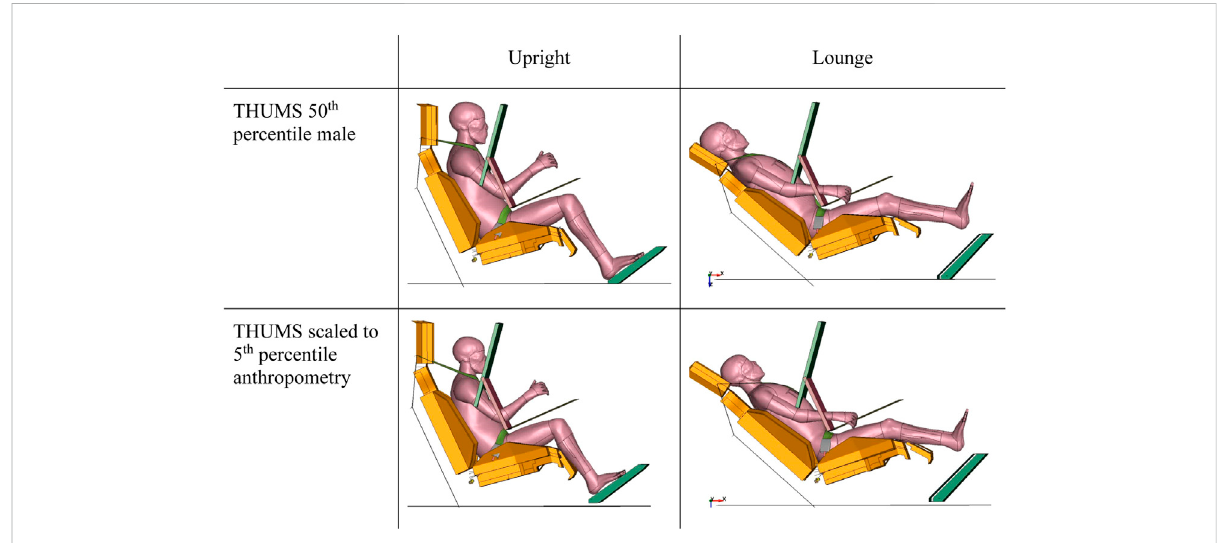
FIGURE 2 AM50 and AF05 THUMS models in upright and lounge seating position.